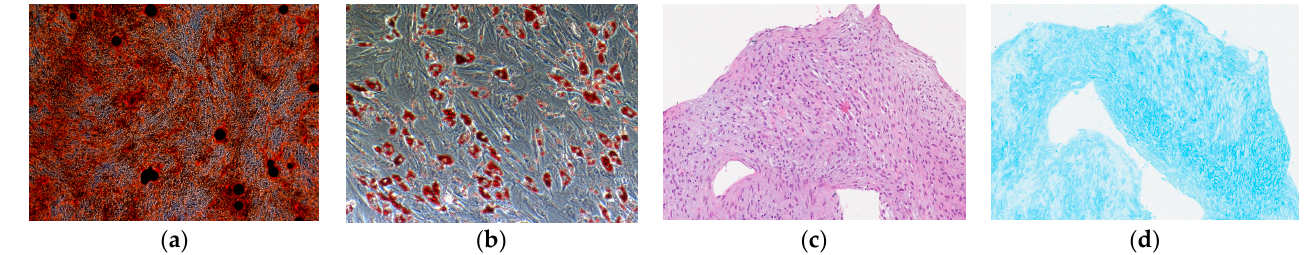
Figure 10. The results of hG-MSCs differentiation in three directions: ( a ) osteogenic (100×, ARS), ( b ) adipogenic (200×, Oil Red O), ( c )chondrogenic (200×, results of histology: immature mesenchymal tissue with a tendency to form cartilage tissue), ( d ) chondrogenic (200×, Alcian Blue).